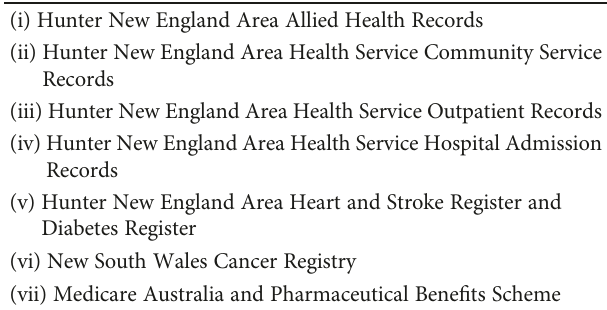
Table 2: Local and national health information databases linked to hunter community study